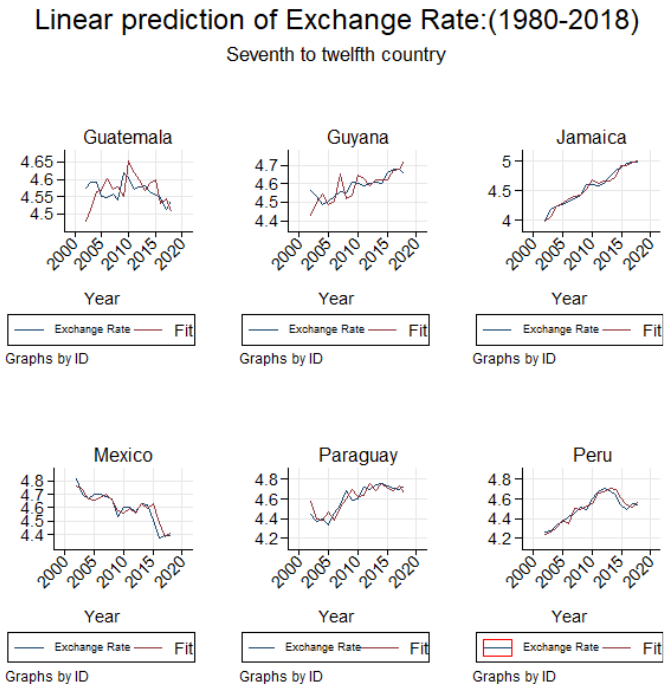
Figure2: Linear Prediction of Exchange Rate (1980-2018)